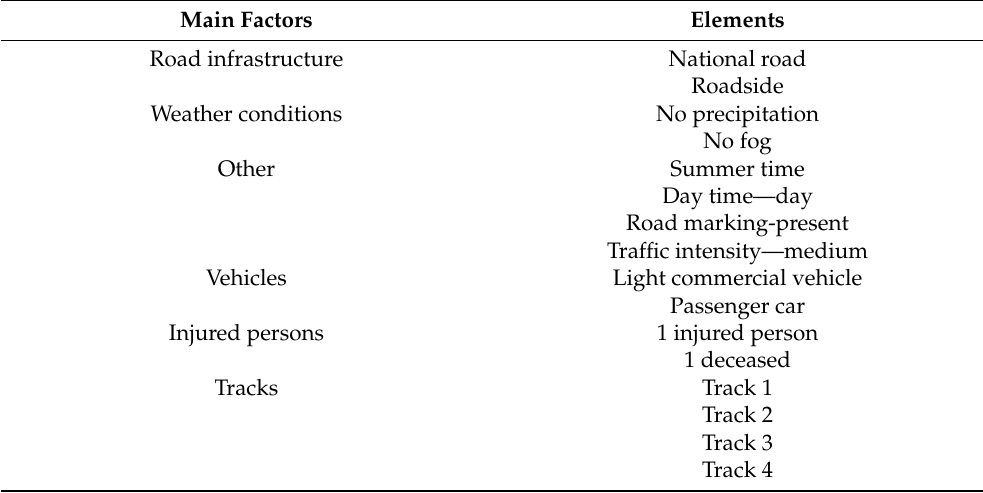
Table 5. Scenario